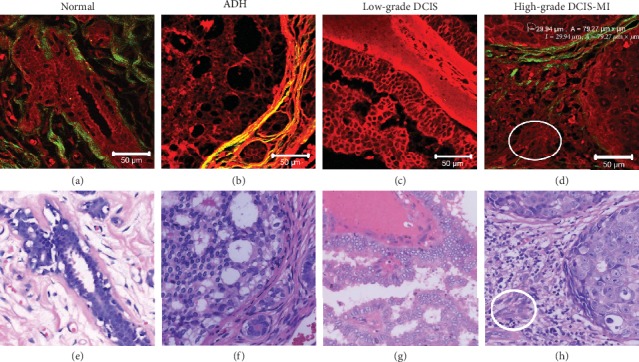
Representative MPM images and corresponding H&E images of the microstructure of normal breast tissue, ADH, low-grade DCIS, and high-grade DCIS-MI. White oval: microinvasion cancer cells; scale bar: 50 μm.